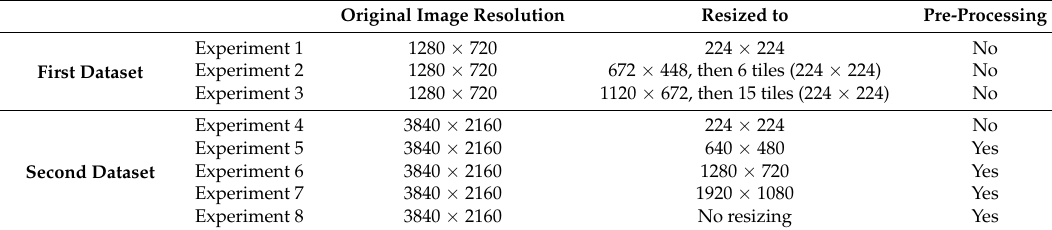
Table 2. General description of experiments conducted.